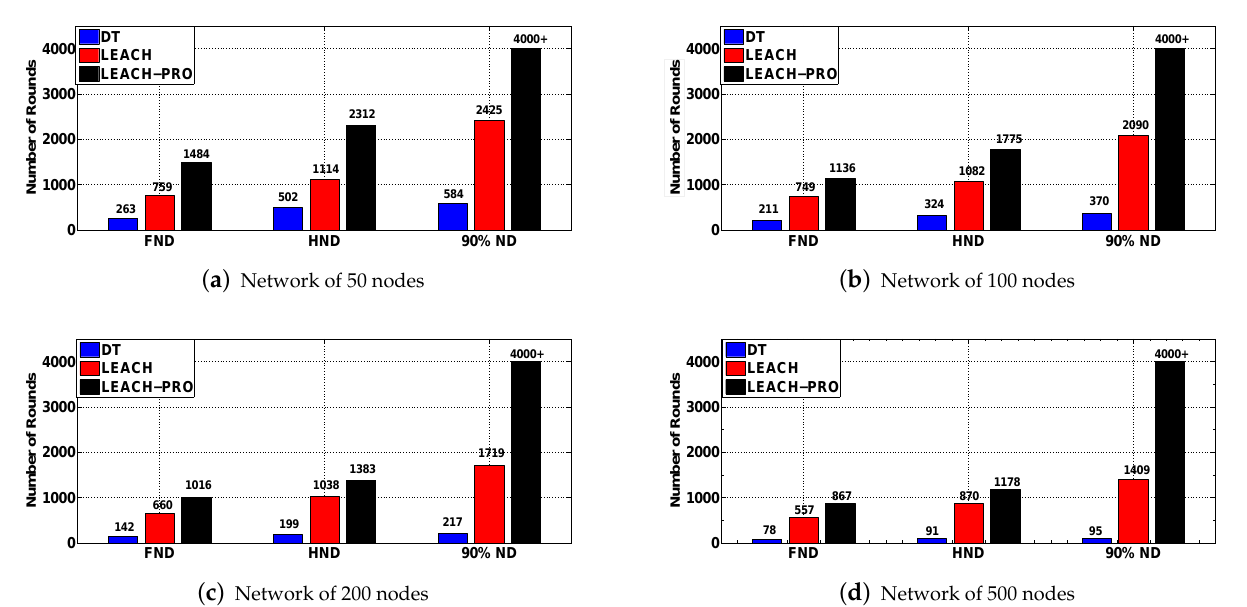
( d ) Network of 500 nodes